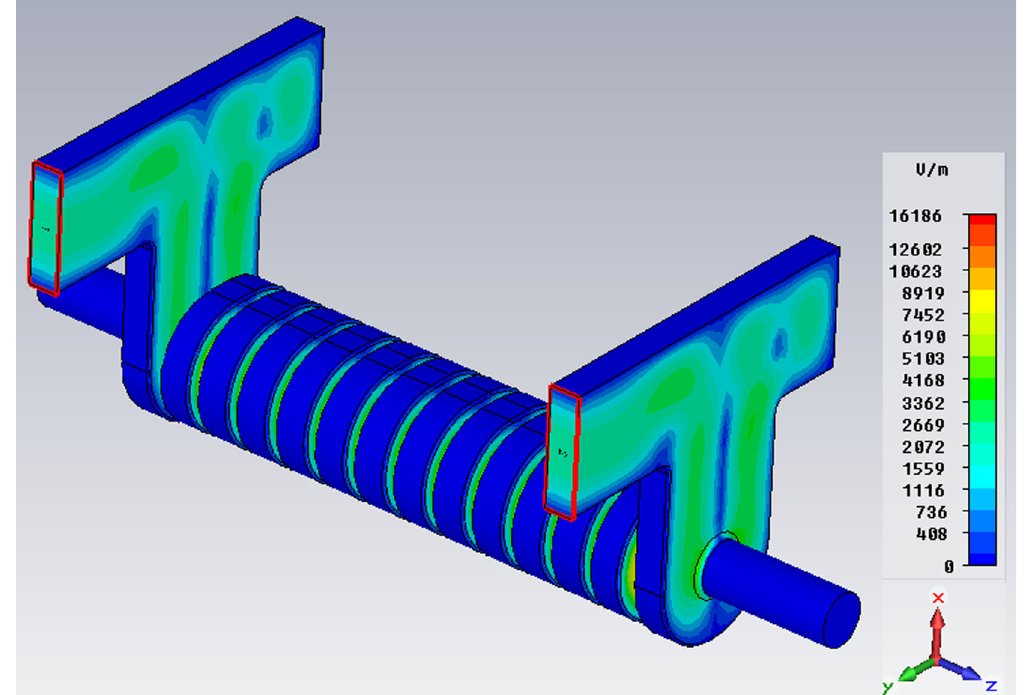
FIG. 19. Single-feed standard coupler with TE